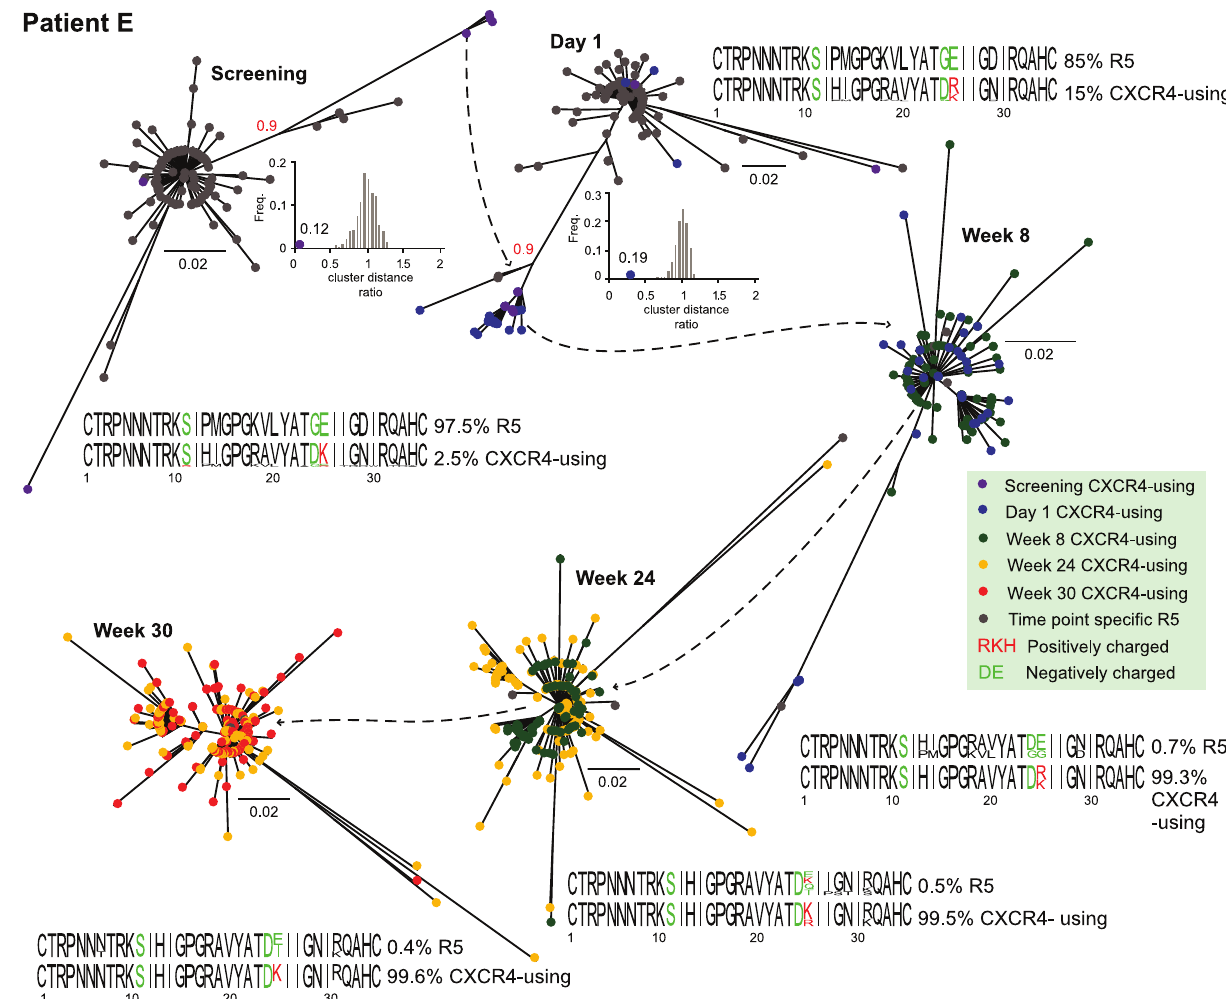
Figure 4. Evolutionary relationships of patient E’s viral population through time. Each phylogeny shows the predicted R5 and CXCR4- using variants for the time points: screening, day 1, week 8, week 24 and week 30. See figure 3’s legend for further details.